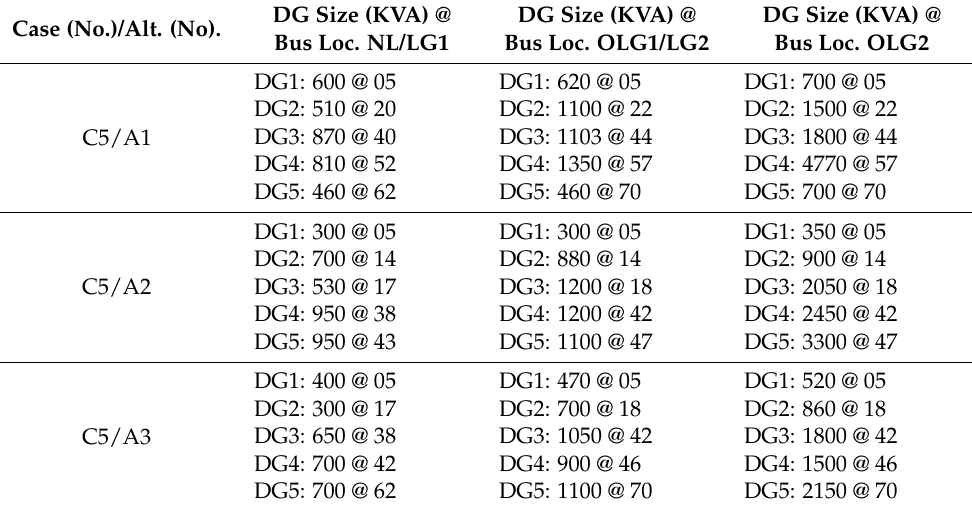
Table 21. DG sitting and sizing at 0.9 LPF for C5/S1–S5 across alternatives in the 75-bus MCMG. Case (No.)/Alt. (No).